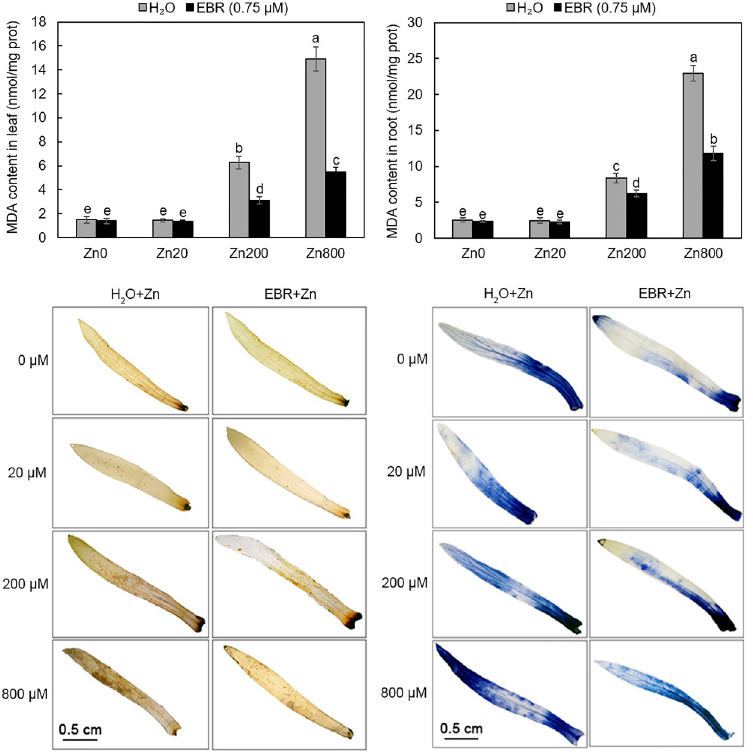
Fig 3. Effect of zinc and EBR on MDA, H 2 O 2 and O2• − contents of S . lineare . (a) MDA levels in leaves; (b) MDA levels in roots; (c) H 2 O 2 accumulation stained with DAB; (d) O 2• − accumulation stained with